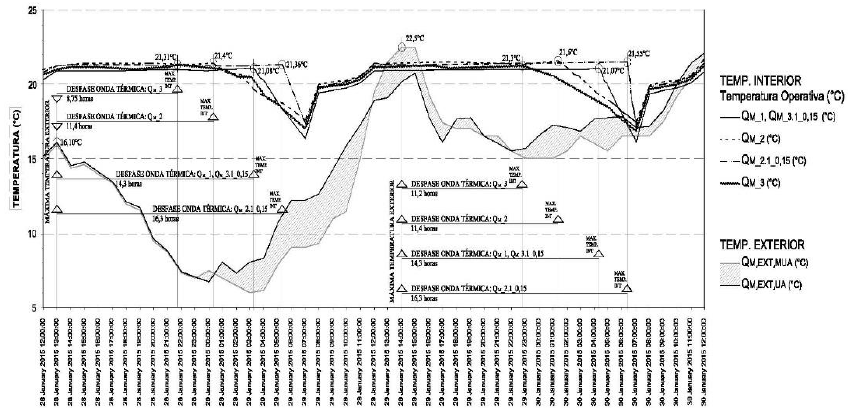
Figure 10. Relationship between outside and indoor ambient temperatures, time lag and decrement factor of the different roof types for the Sempere Hall at the MUA.